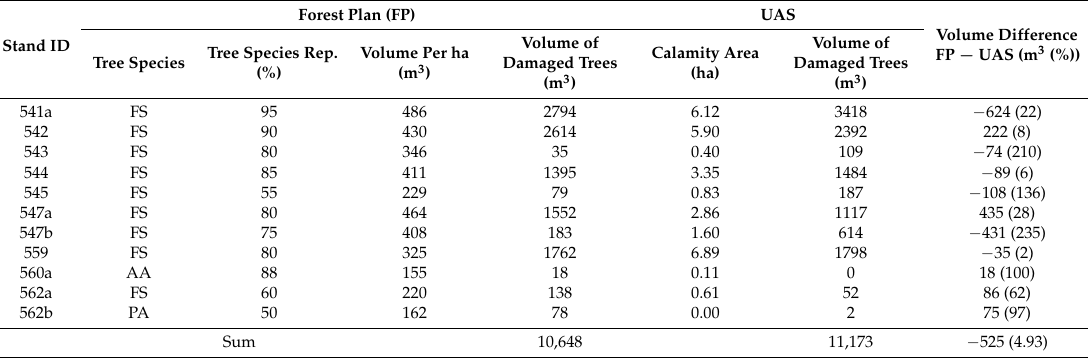
Table 6. Volume estimation of salvage logging based on the data from the forest plan and from